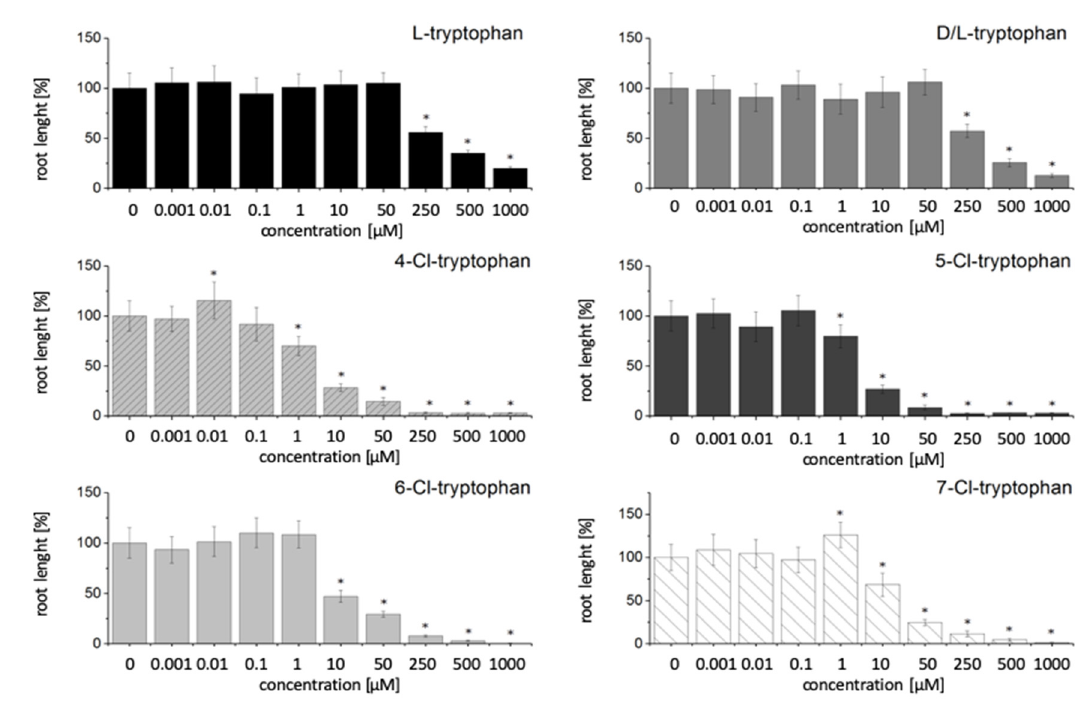
Figure 1. Effect of tryptophan (Trp) and chlorinated Trp derivatives on root length of A. thaliana wild type plants. Since all Cl-derivatives were the D/L racemic mixtures, we included the D/L racemate as comparison, but we were also interested to see whether L-Trp had a different effect which was not the case. Concentrations are given in µM. Shown are the relative root lengths 17 days after incubation on different Trp-containing media. The results are calculated based on the control plants without any treatment to make them more comparable between different experiments. Significant differences of p<0.05 in comparison to the control plants are labeled with *. Data are mean values of N> 50 ± SD.